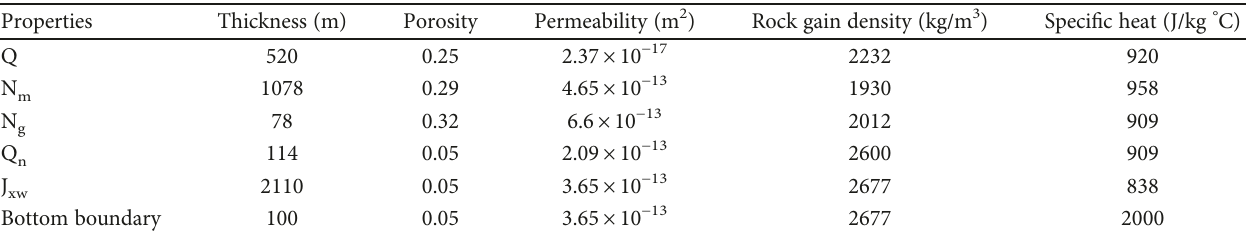
Table 2: Key thermal properties of the western thermal reservoir of Cangdong Fault (the solid rectangular zone as shown in Figure 1(c)) (Q: Quaternary caprock; N : Minghuazhen group of Neogene; N m group of Jixian).